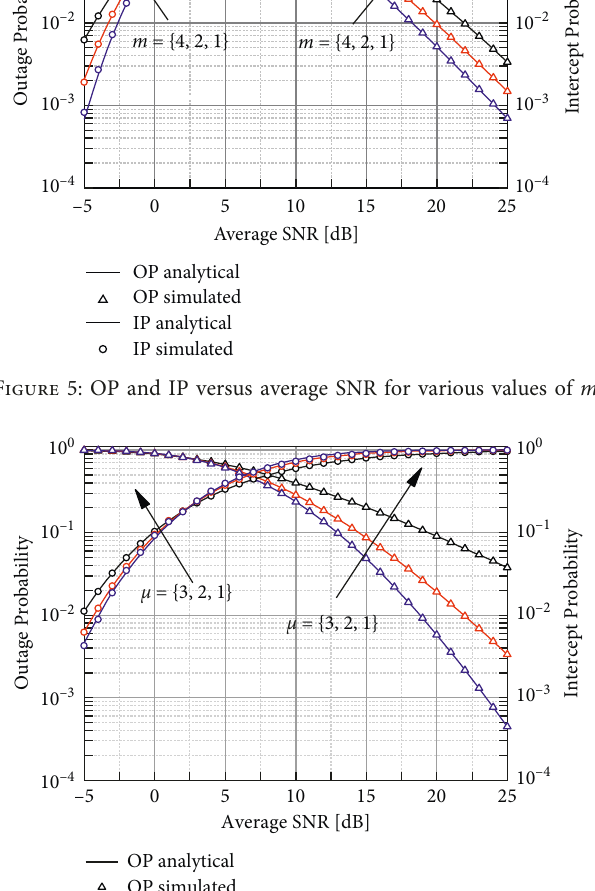
Figure 6: SOP OP and IP versus average SNR for various values of μ